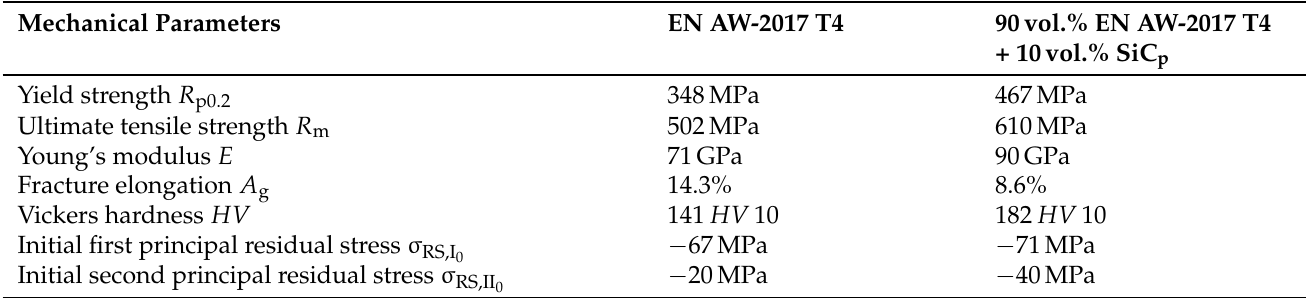
Table 1. Mechanical properties of the investigated composite consisting of 90vol.% EN AW-2017 + 10vol.% SiC p adapted from [23,24] and the assigned unreinforced matrix alloy.